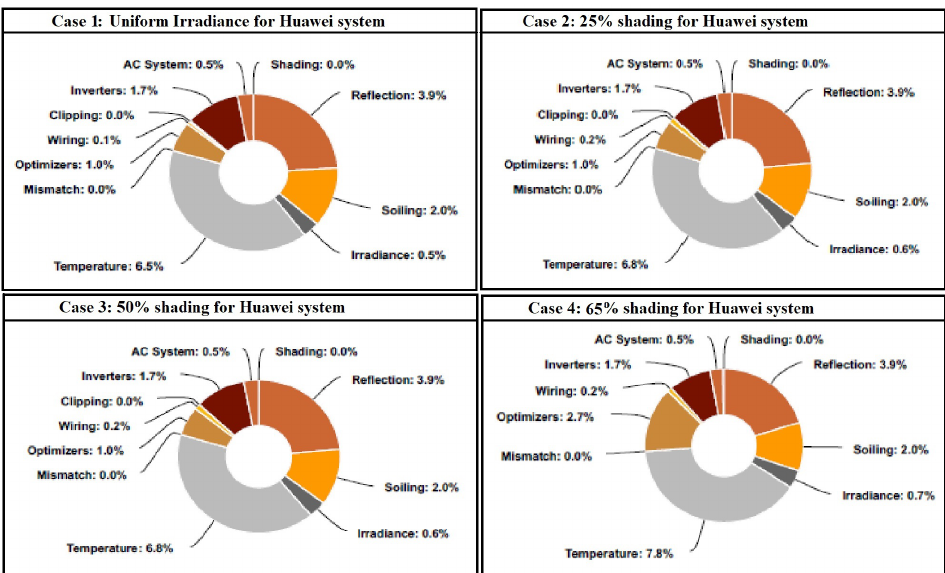
Figure 39. Results of various losses of Huawei Solar system on different shading conditions using Helioscope.